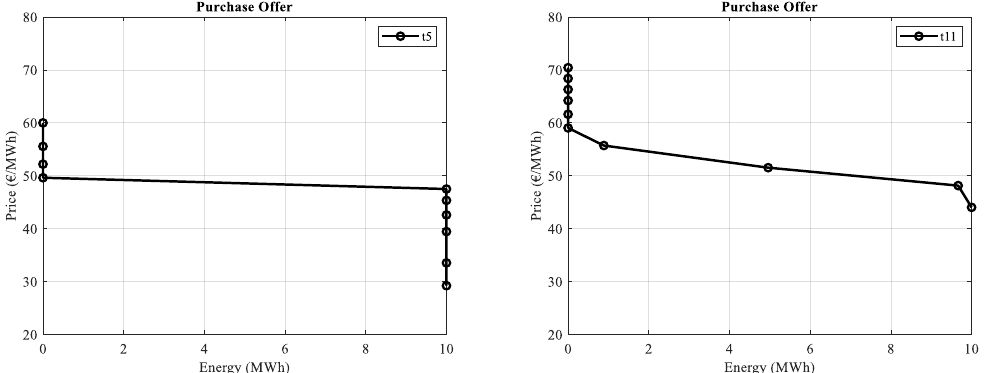
Figure 6. Purchase offering curves: left , hour 5; right , hour 11.